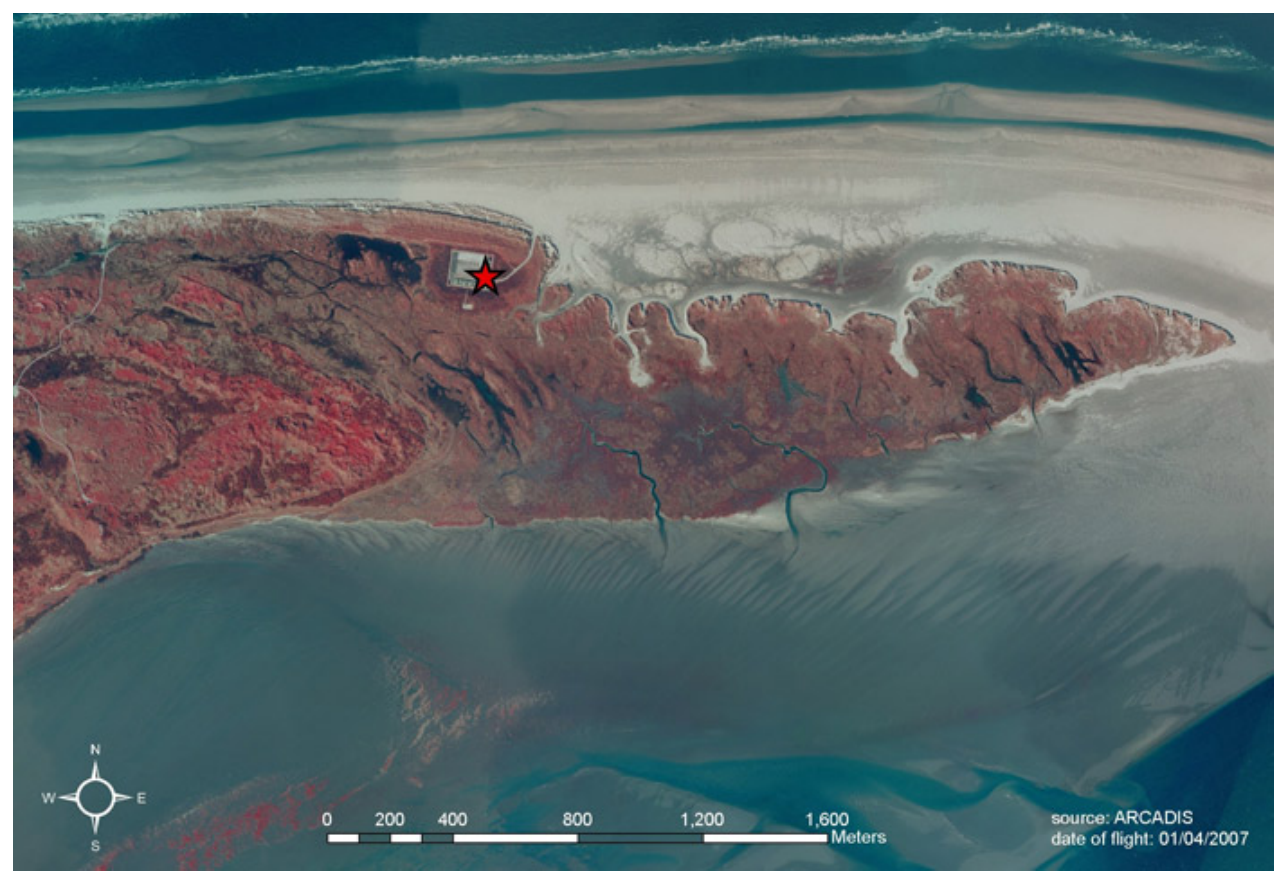
Fig. 3. Aerial view of the study area on 1 April 2007 (false color image produced by ARCADIS). The uninhabited eastern cape of the barrier island Ameland (Dutch Wadden Sea) is shown. The red star indicates the location of the artificial light source used for